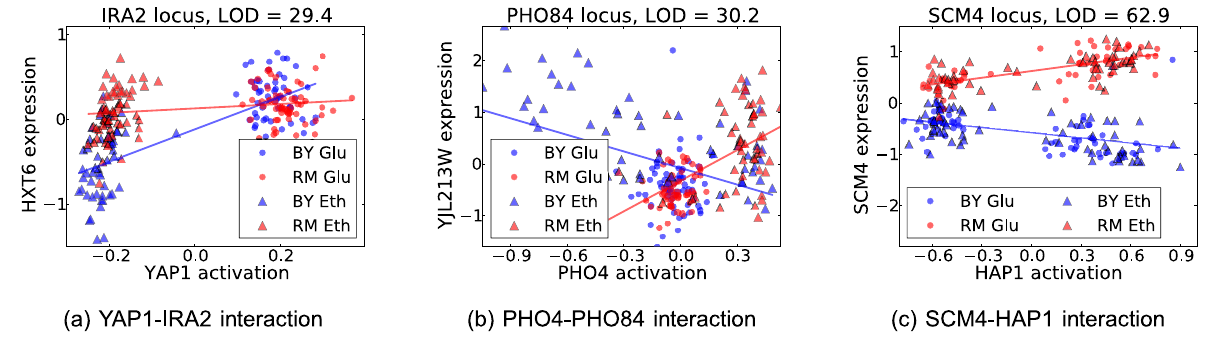
Figure 2. Three broad classes of interaction effects between locus genotype and transcription factor activation affecting gene expression (for details see text). Each marker shows the gene expression and factor activation for one individual segregant of either BY (blue) and RM (red) background at the locus, and grown in ethanol (triangles) or glucose (circles) as a carbon source. Maximum likelihood fits for expression data for the BY and RM segregants are plotted as solid lines; an interaction effect corresponds to a difference in slope in the two genetic backgrounds. (a) Genotype-environment interaction mediated by the inferred YAP1 transcription factor activation. (b) Interaction between the PHO84 locus and PHO4 transcription factor activation, which is associated both with the PHO84 locus genotype and the PHO4 probe expression level. (c) Epistatic interaction between HAP1 and its target, SCM4 , mediated by the HAP1 activation.